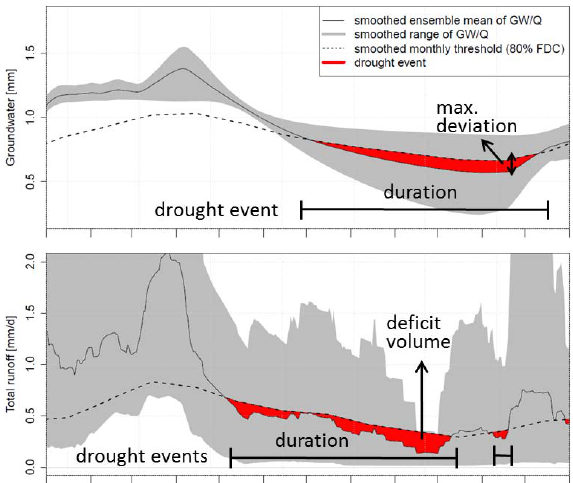
Fig. 2. Threshold level method with variable threshold (80th per- centile of monthly duration curve, smoothed by 30-day moving av- erage) for groundwater storage (GW; state variable; upper row) and total runoff ( Q ; flux; lower row), including an illustration of drought characteristics duration, deficit volume, and maximum